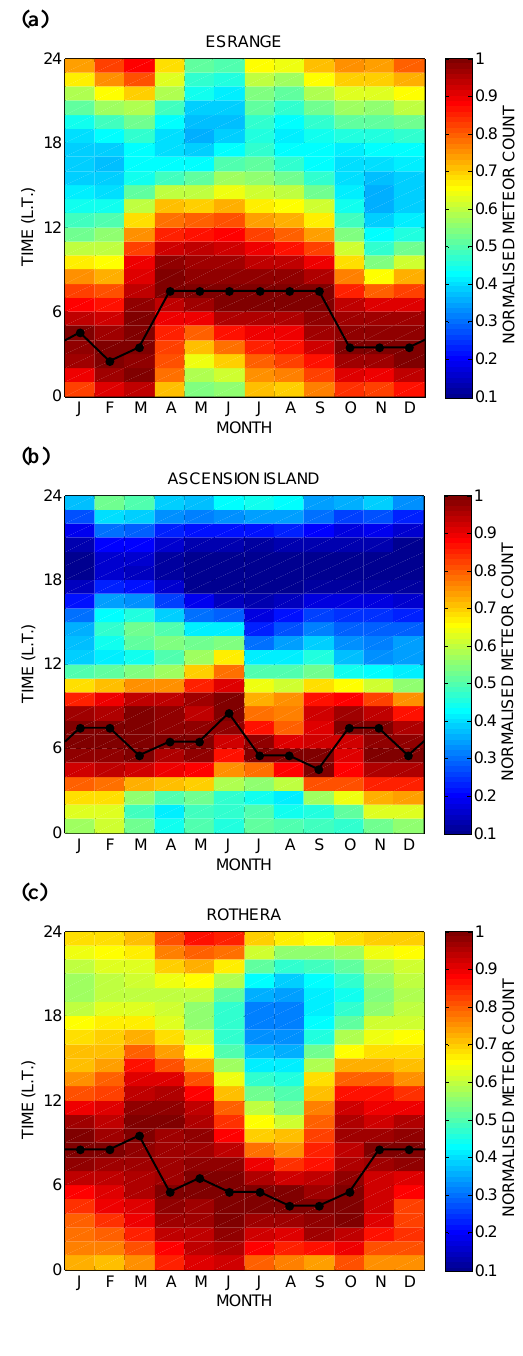
Figure 3 Fig. 3. Contour plots showing diurnal variation of hourly meteor count rates (in local time) at (a) Esrange (1999–2008), (b) Ascen- sion Island (2001–2007), and (c) Rothera (2005–2008). Note the annual variations in meteor count